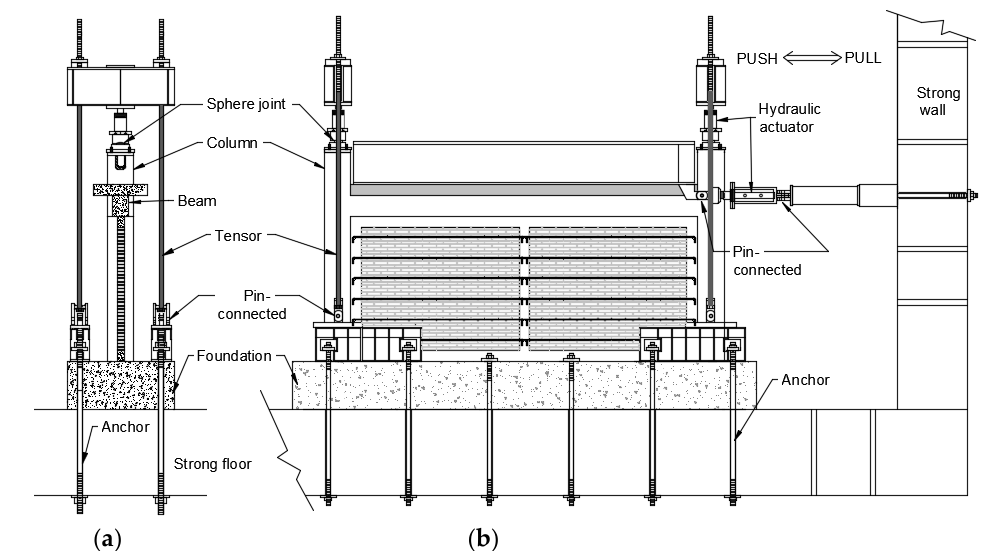
Figure 5. Test setup. ( a ) transverse view, ( b ) elevation view.